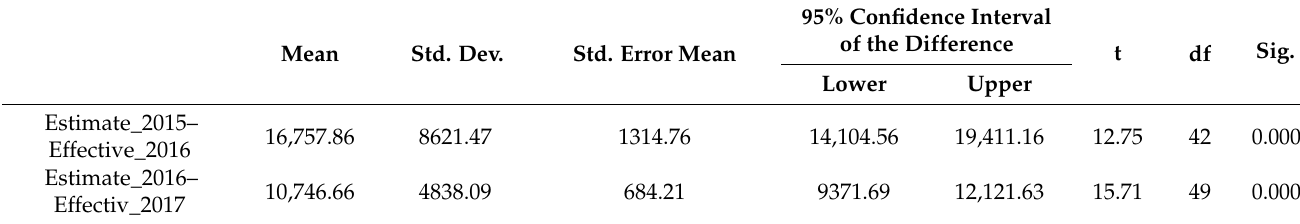
Table 2. Paired sample